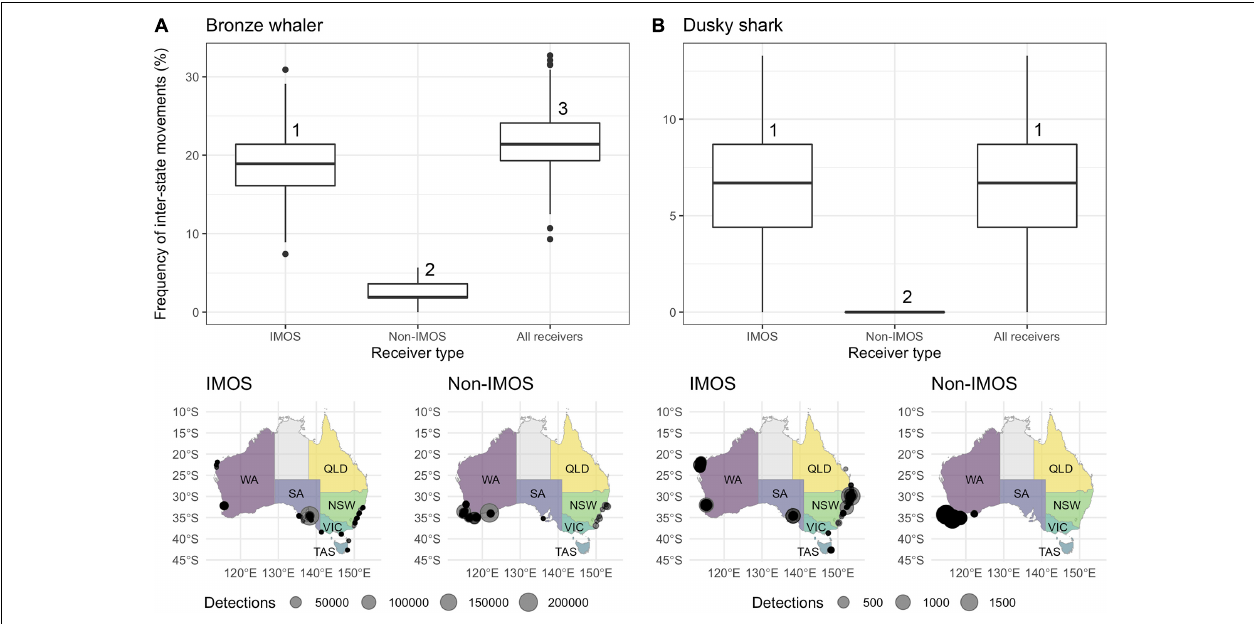
FIGURE 5 | Top panel: Simulation results of frequency distributions of inter-state movements recorded for (A) bronze whalers and (B) dusky sharks using receivers from IMOS, non-IMOS, and a combination of both (All receivers). Numbers above boxes represent the significantly different groups according to the Tukey post hoc test. Bottom panel: Acoustic detections of (A) bronze whalers and (B) dusky sharks by receiver type (IMOS vs.